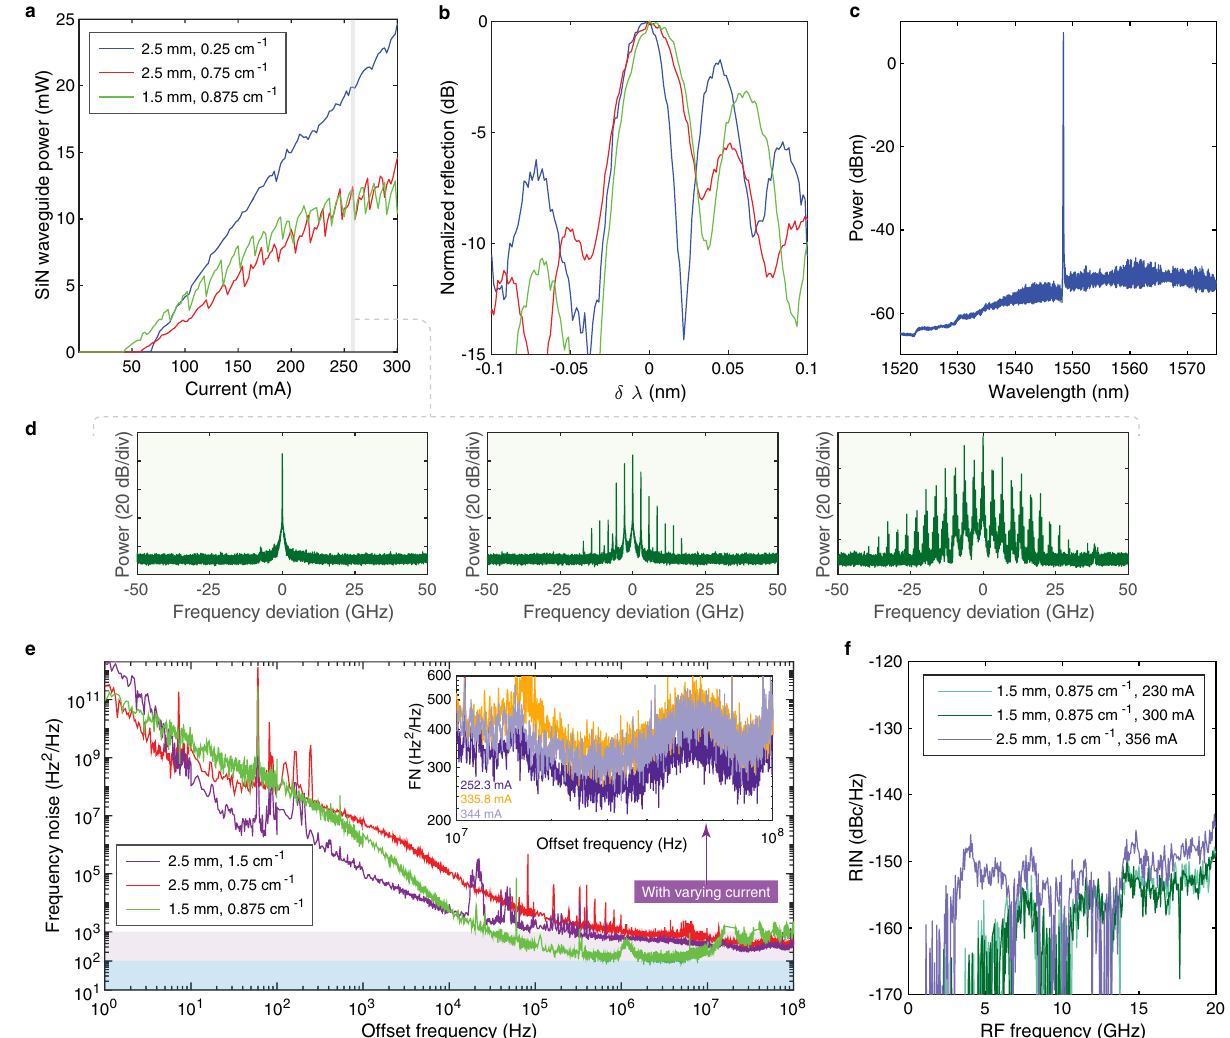
Fig. 2 Laser characterization. a LI measurements of three lasers with different gain section length (1.5 mm or 2.5 mm) and grating κ values (0.25 cm − 1 , 0.75 cm − 1 , and 0.875 cm − 1 ). b Corresponding grating re fl ection response of lasers measured in ( a ). c Optical spectrum of the high-power laser (shown in blue in a and b ) at a gain current of 300 mA. The optical spectrum analyzer resolution bandwidth is 0.02 nm. d Single-mode and multimode regimes as the wavelength are red-tuned across a mode-hop cycle, commonly observed in DBR lasers 29, 35 . The corresponding laser gain currents from left to right are 254.4, 258, and 261 mA, respectively. e Laser frequency noise spectrum of lasers with low-frequency noise and either kHz or sub-kHz level fundamental linewidth. The laser currents are 252.3 mA (purple), 382.2 mA (red) and 298mA (green). Inset shows current-dependent high-offset frequency noise spectra for the laser with 2.5 mm gain section length and 1.5 cm − 1 grating κ value (purple), indicating sub-kHz level Lorentzian linewidth is achieved for all three currents. f Laser RIN measurements of a low-threshold laser (shown in green in a and b ) and another laser (shown in purple in e